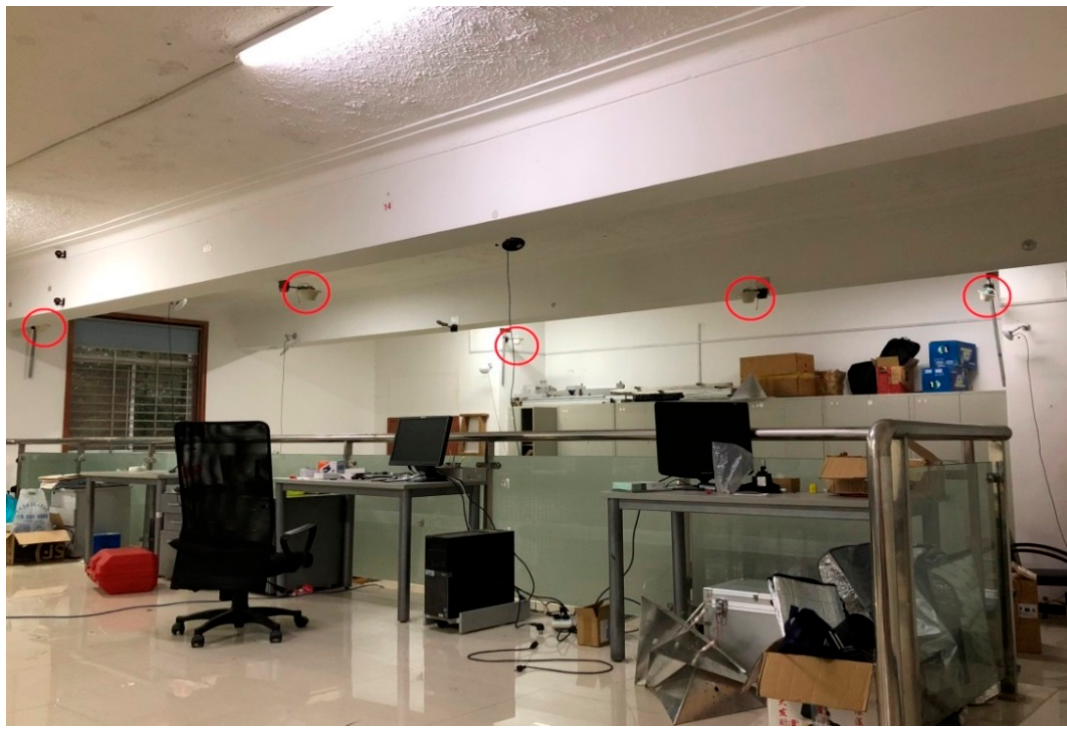
Figure 3. Distribution of pseudolite antennas.